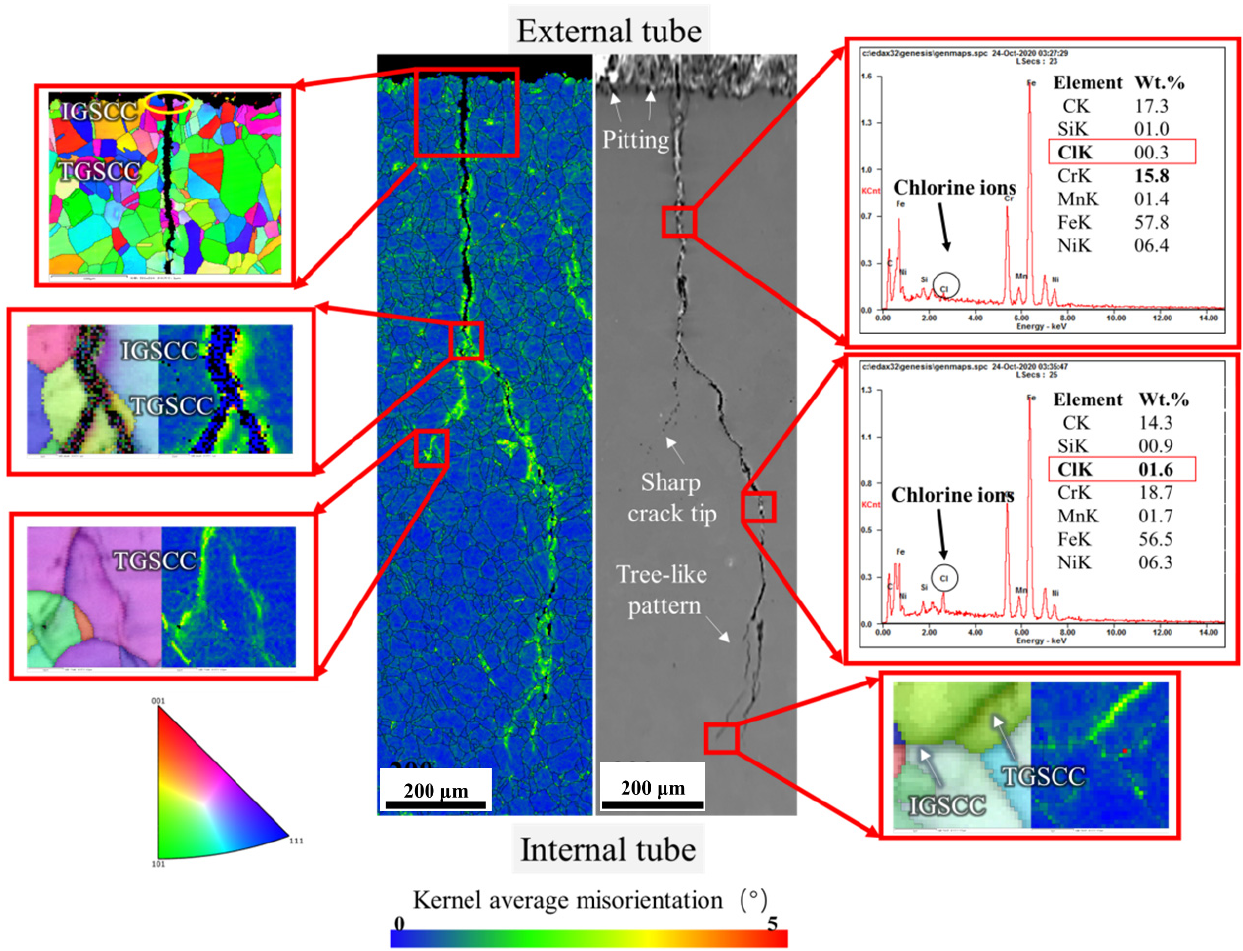
Figure 8. The EBSD result of an entire secondary crack.